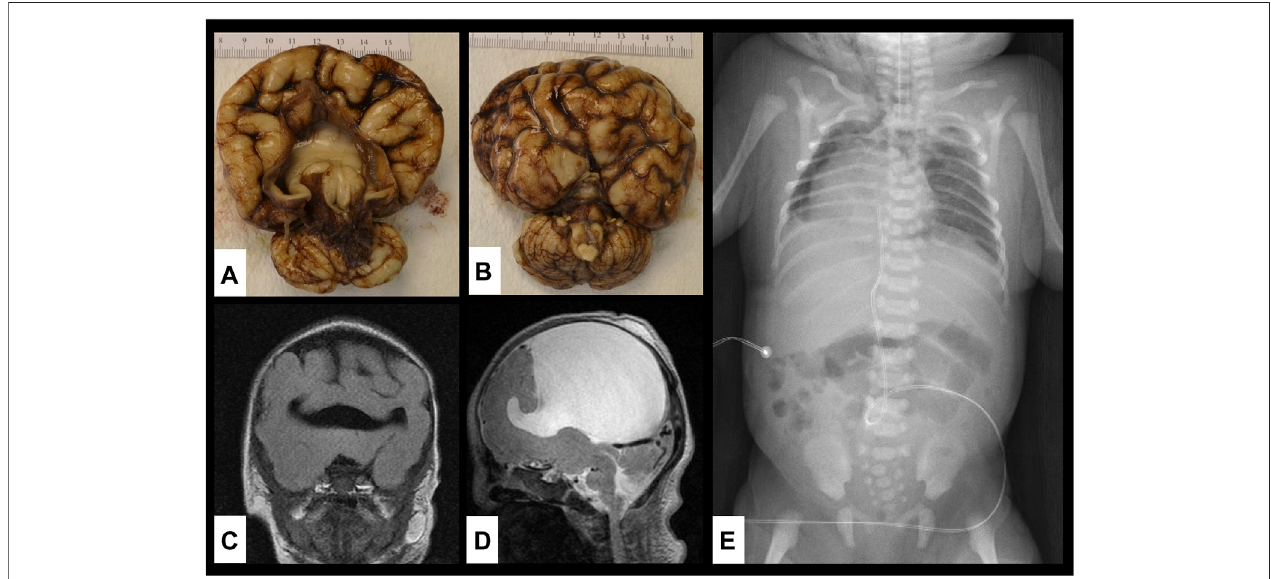
FIGURE 2 | Brain and vertebral abnormalities. (A,B) Gross specimen of the brain on autopsy showing alobar holoprosencephaly with disordered gyral pattern, a single common ventricle, a large dorsal cyst (contained 85 ml cerebrospinal fl uid) and absence of the olfactory tracts and bulbs; (C,D) MRI of the brain showing single ventricle and alobar holoprosencephaly; (E) X-ray ofchestand abdomen showing dextroposition of the heart, segmentation abnormalities of multiple thoracic vertebrae and absent left lateral portion of S2